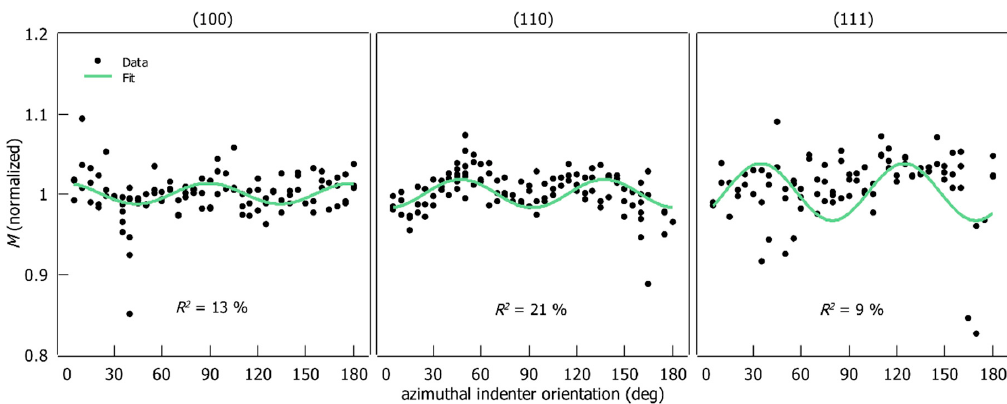
Figure 9. M (normalized to the mean values) as a function of the azimuthal indenter orientation on three crystallographic orientations.